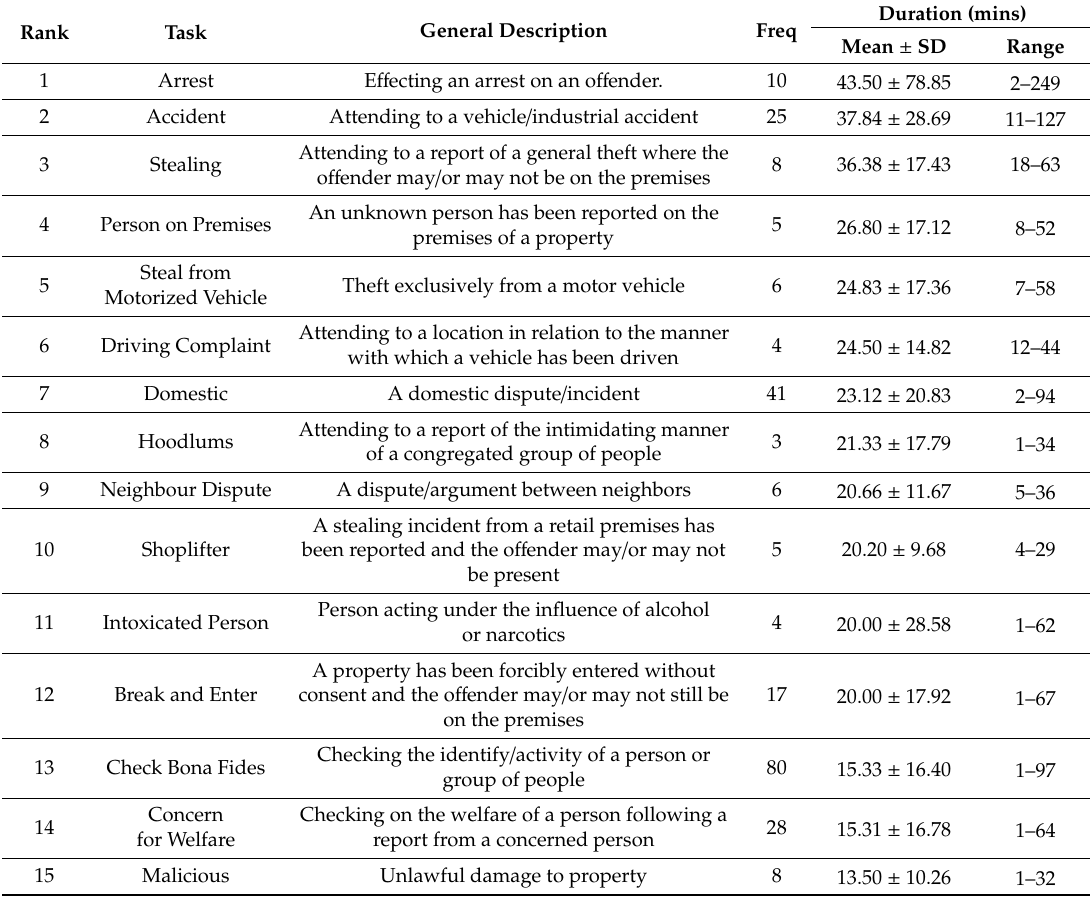
Table 3. Top 15 tasks, by mean duration, as reported on the CAD